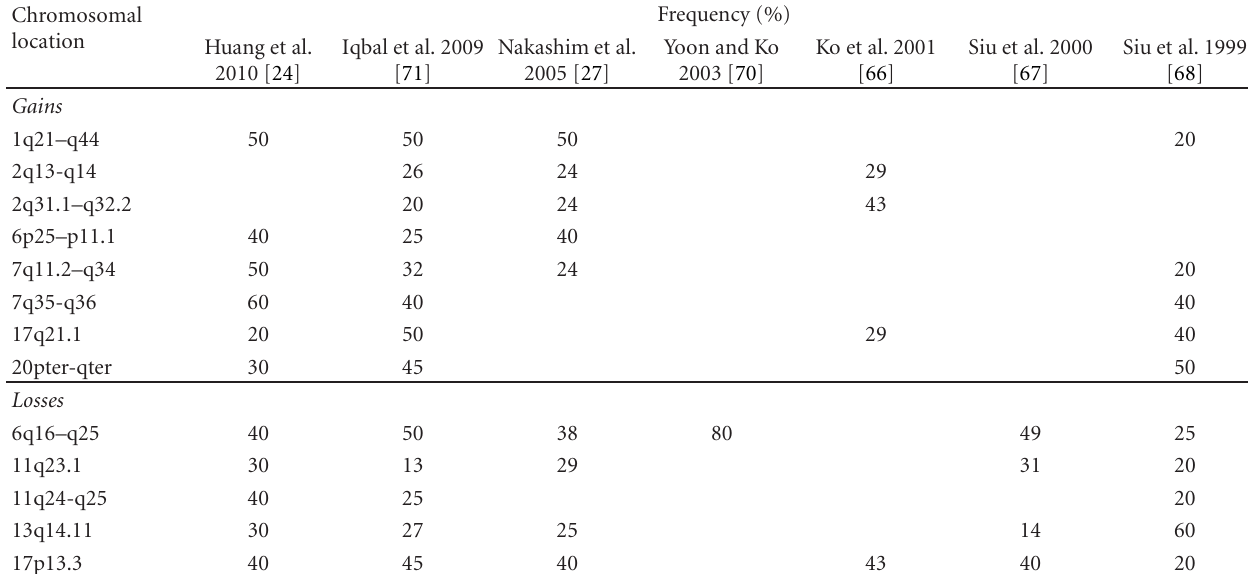
Table 1: Recurrent genomic alterations in extranodal NKTCL from published data.